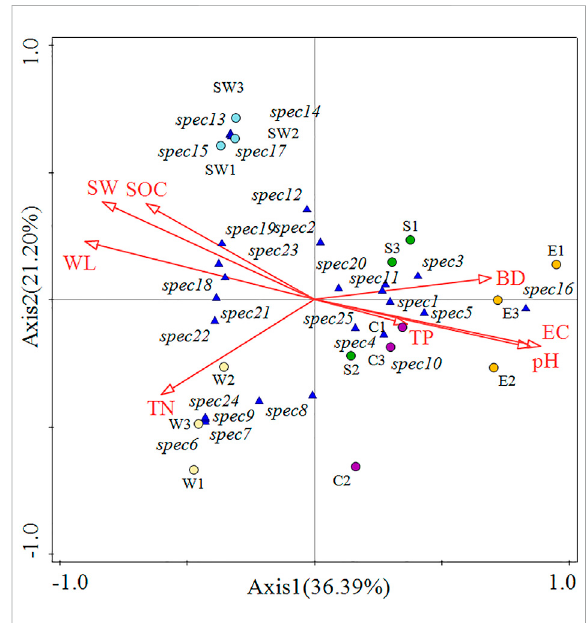
FIGURE 6 Canonical correspondence analysis ordination analysis of species distribution and environmental factors (WL, Water level; EC, Water conductivity; BD, Bulk density; SW, Soil moisture content; SOC, Soil organic carbon; TN, Total nitrogen; TP, Total phosphorous). spec1. Carex schmidtii Meinsh. spec2. Thelypteris palustris (L.) Schott. spec3. Lythrum salicaria L. spec4. Lysimachia davurica Ledeb. spec5. Phragmites australis (Cav.) Trin. ex Steud. spec6. Carex tenui fl ora . spec7. Menyanthes trifoliata L. spec8. Saussurea japonica (Thunb.) DC. spec9. Viola verecunda A. Gray. spec10. Sanguisorba teriuifolia var. Alba Trautv. spec 11. Ligularia sibirica (L.) Cass. spec 12. Geranium wilfordii Maxim. Spec